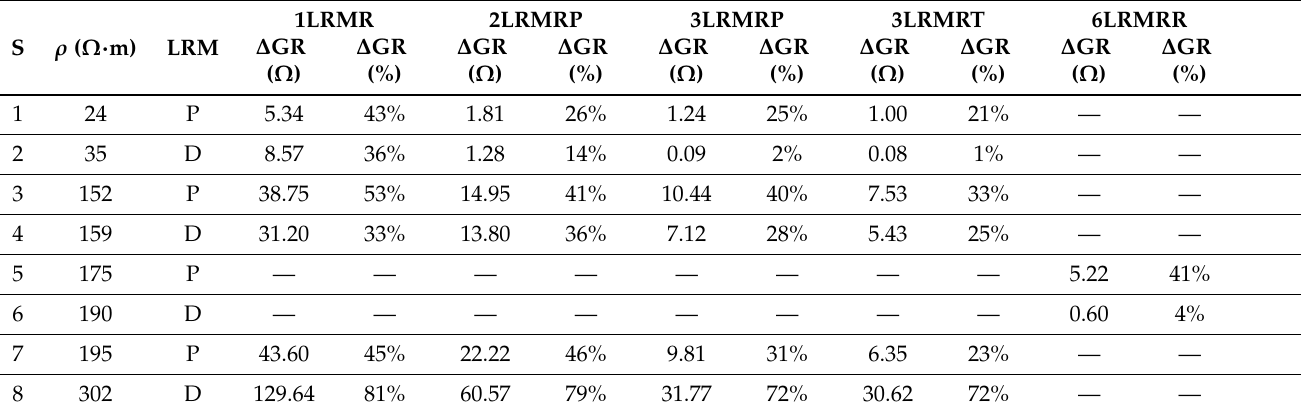
Table 11. Summary of the results of the LRM effect.